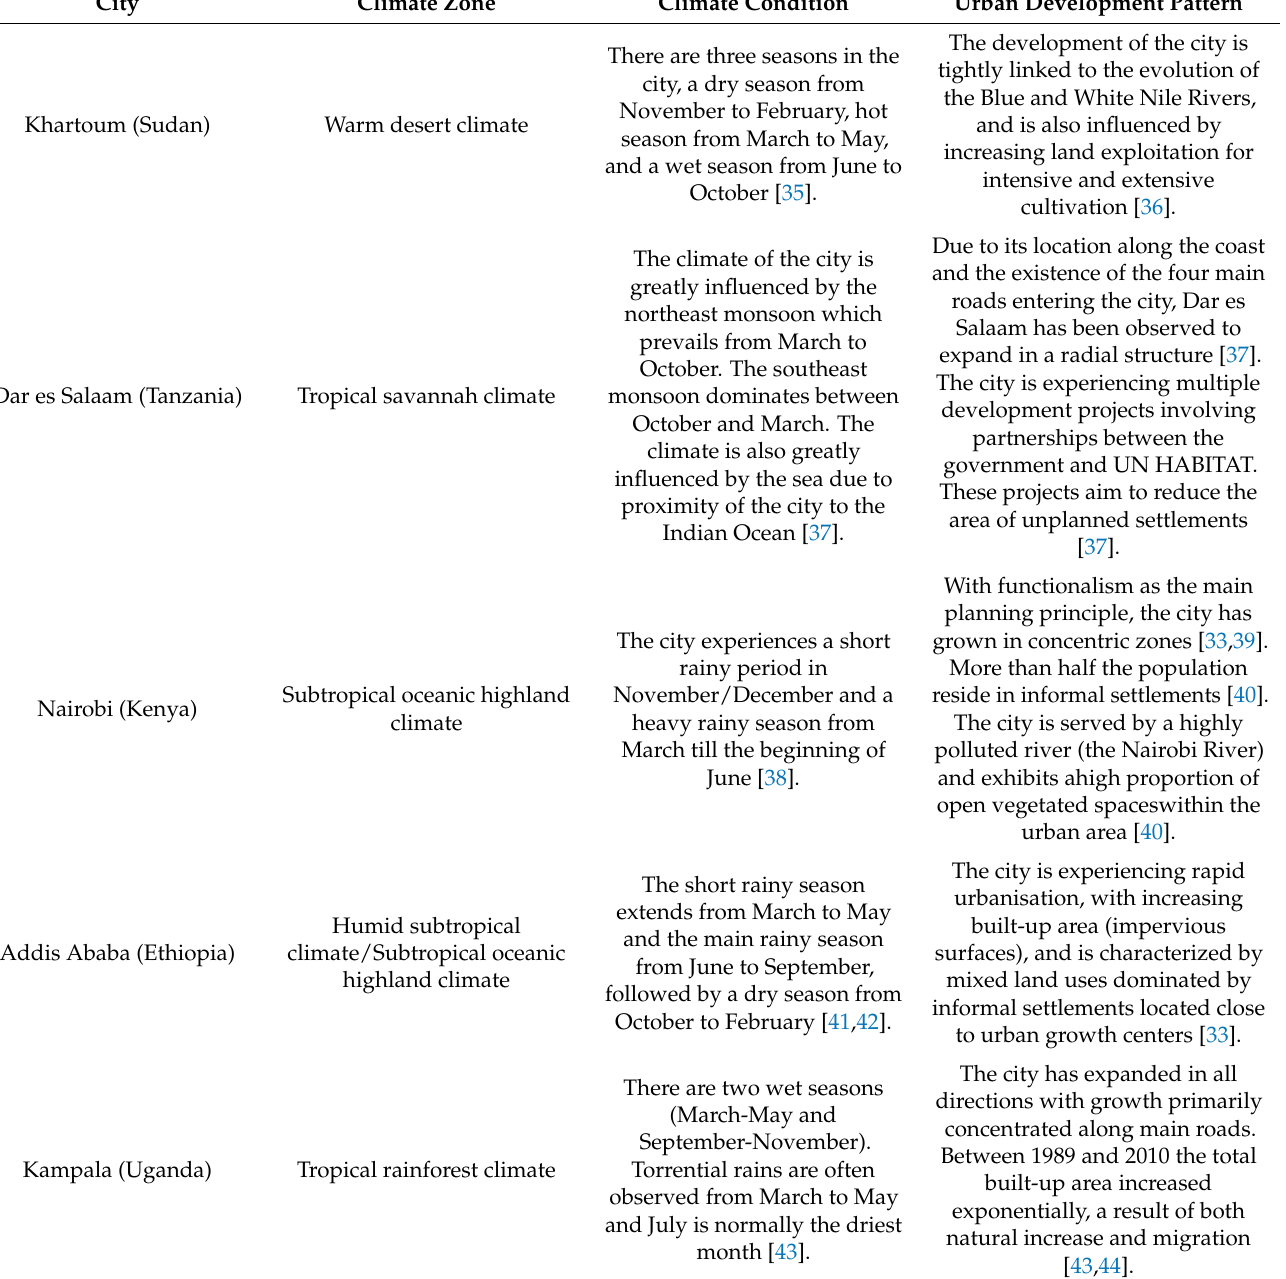
Table 2. Climate zones and urban development information of the study